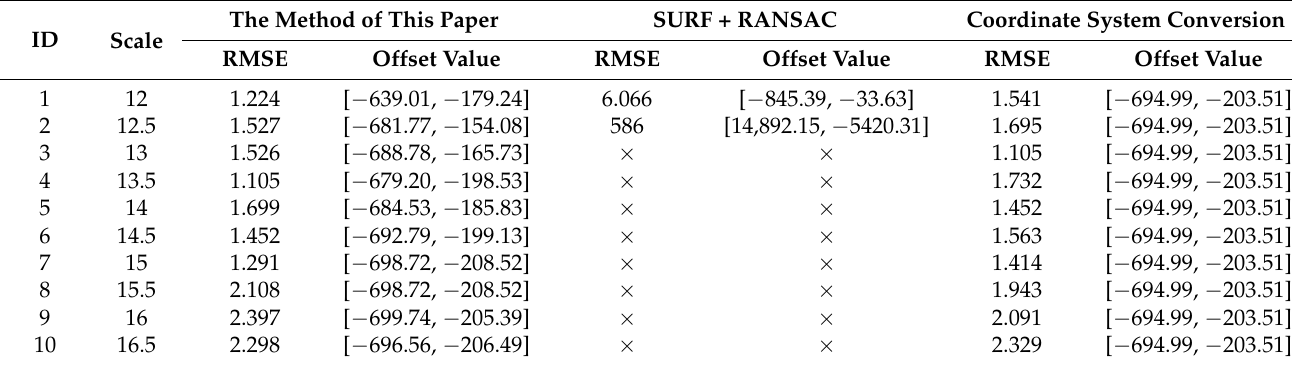
Table 4. Registration results of three methods in vector maps of Beijing.